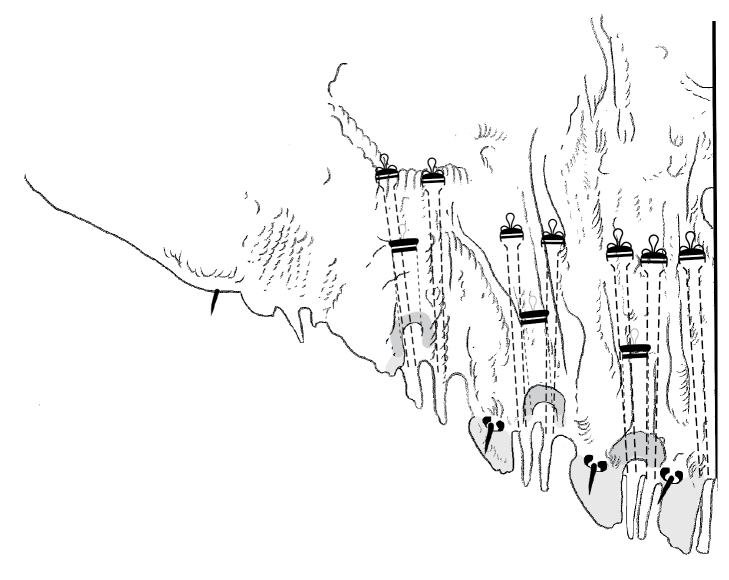
Pygidium of 2nd instar of Greenielladacrydiae sp. n.